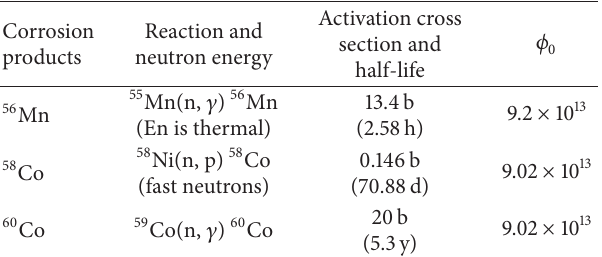
Table 1: Activated corrosion products and their reaction properties